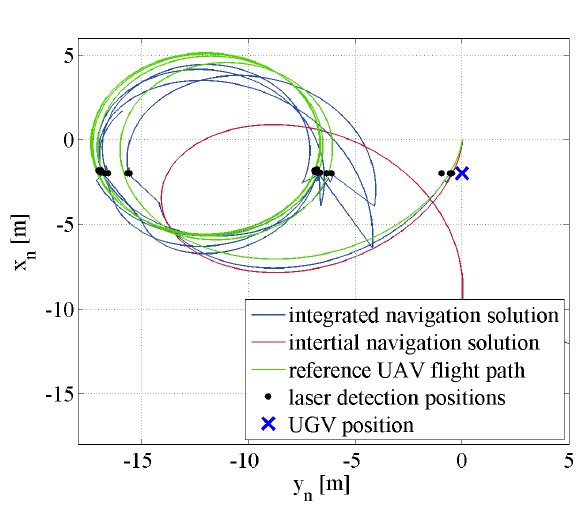
Figure 8: Estimated flight path of pure INS, integrated navigation solution and reference during the simulation